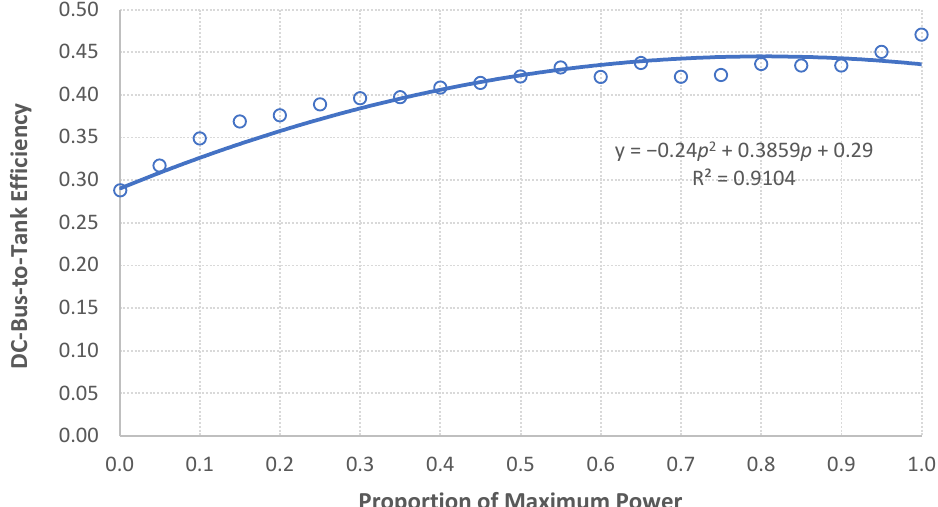
Figure 5. Estimated DC-bus-to-tank efficiency as a function of the proportion of power to the maximum power.